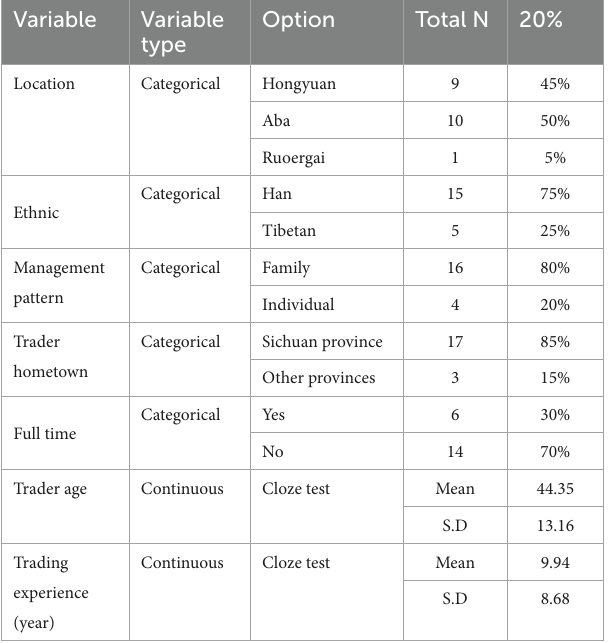
TABLE 1 Sample characteristics of traders in Hongyuan